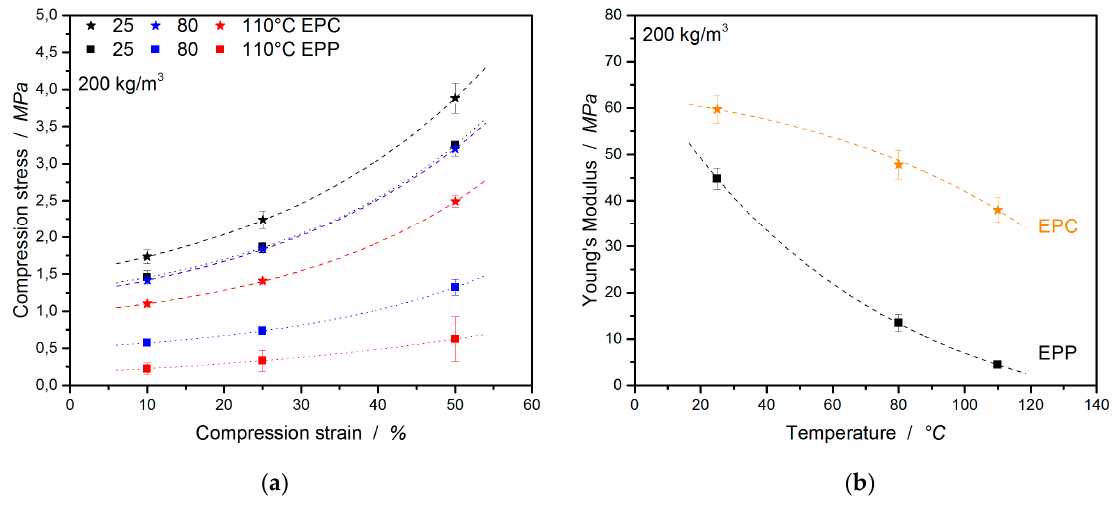
Figure 5. Comparison of compression strength ( a ) and compression moduli ( b ) of EPC and EPP at 25, 80, and 110 °C.